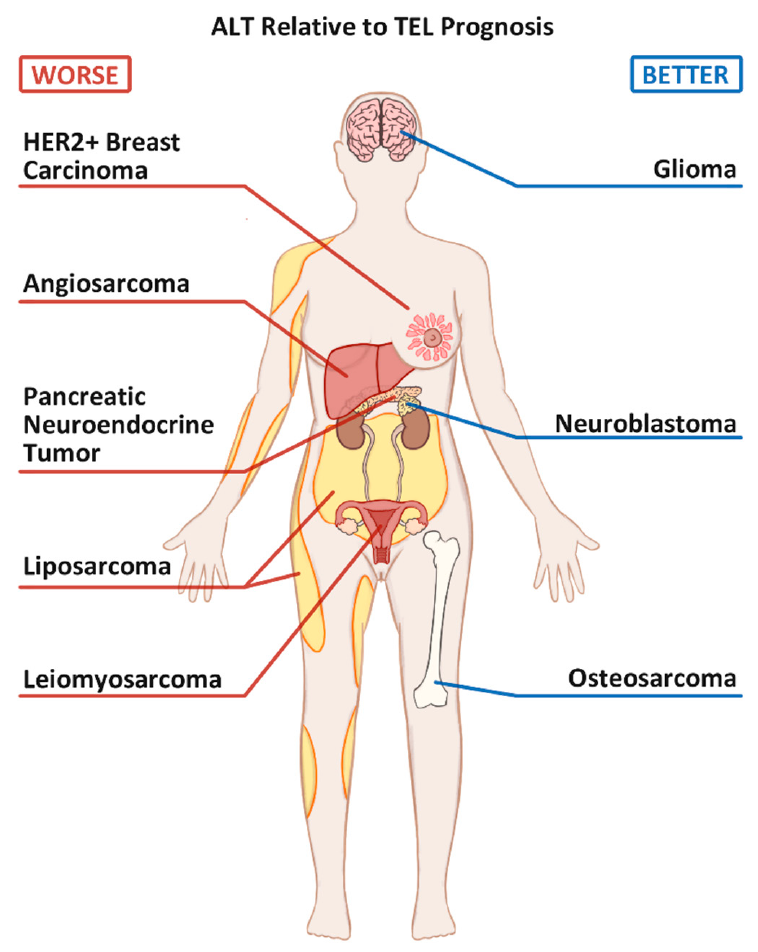
Figure 1. Commonly seen Alternative Lengthening of Telomeres positive (ALT+) cancers and their prognoses relative to their Telomerase positive (TEL+) counterparts. Table 1. Markers used to distinguish cancers based on their telomere maintenance mechanism.